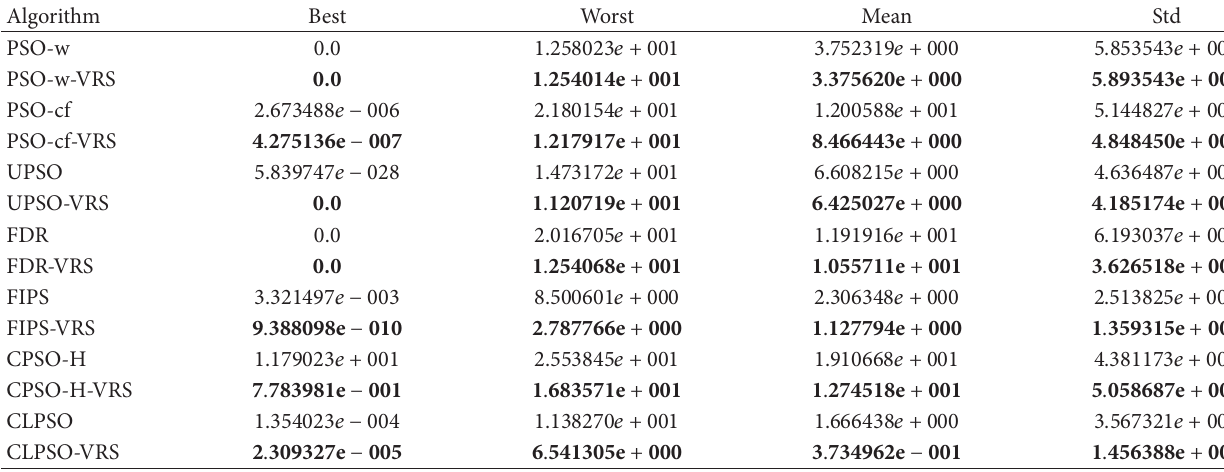
Table 2: Optimization results obtained for the frequency-modulated synthesizer optimization problem; the results obtained by EAs with VRS are shown in